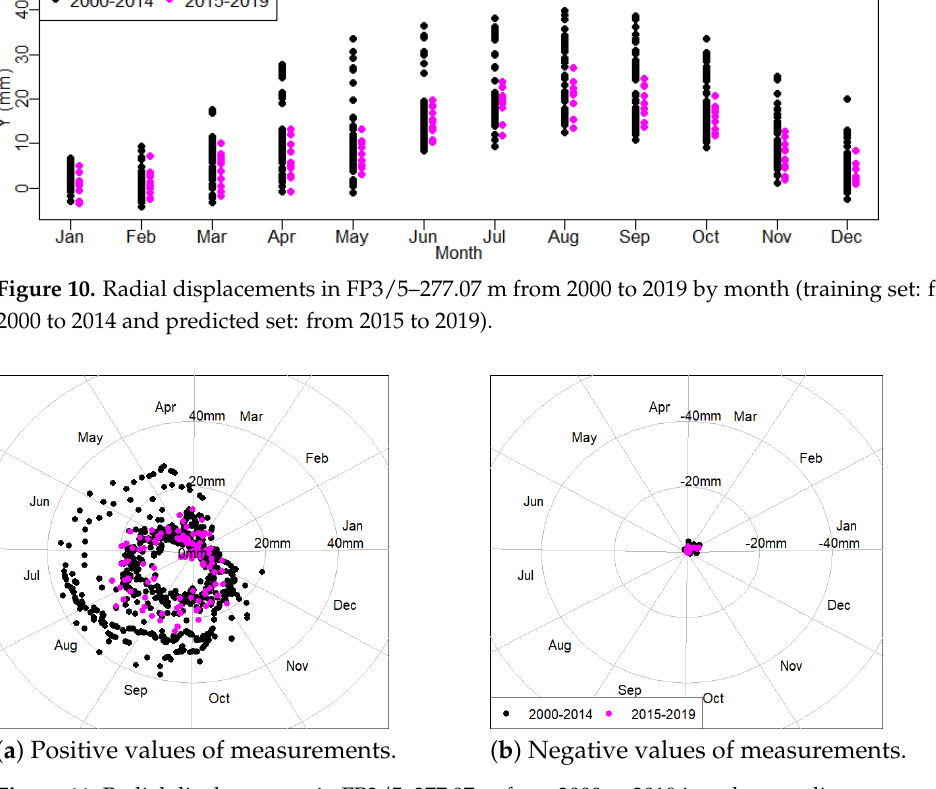
Figure 11. Radial displacements in FP3/5–277.07 m from 2000 to 2019 in polar coordinate system, by month (training set: from 2000 to 2014 and predicted set: from 2015 to